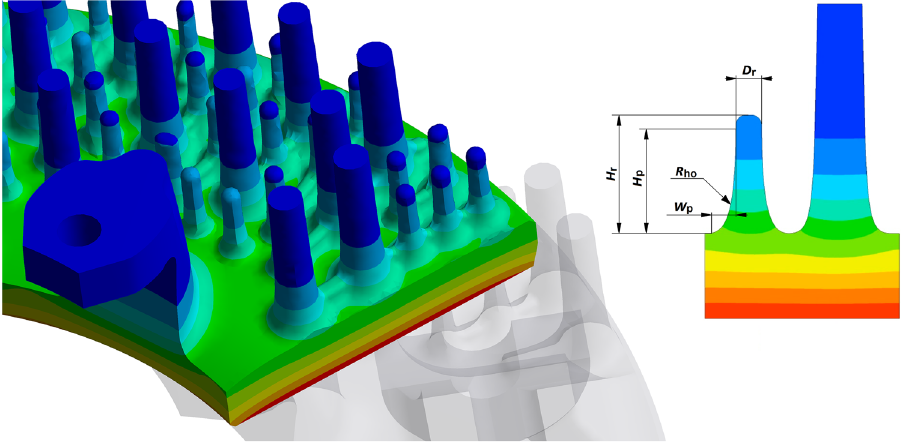
Fig. 5 Representation of low-profile cooling